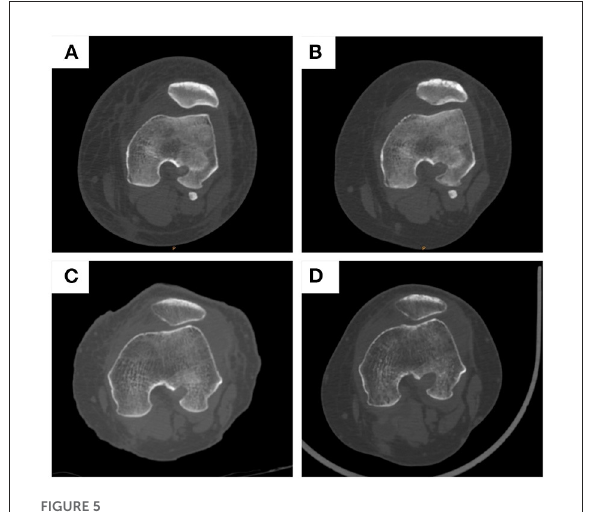
FIGURE5 CT examination of patients in group 1 and group 2 at 2 weeks and 3 months post-operation. (A) patients in group 1 at 2 weeks post-operation; (B) patients in group 1 at 3 months post-operation; (C) patients in group 2 at 2 weeks post-operation; (D) patients in group 2 at 3 months